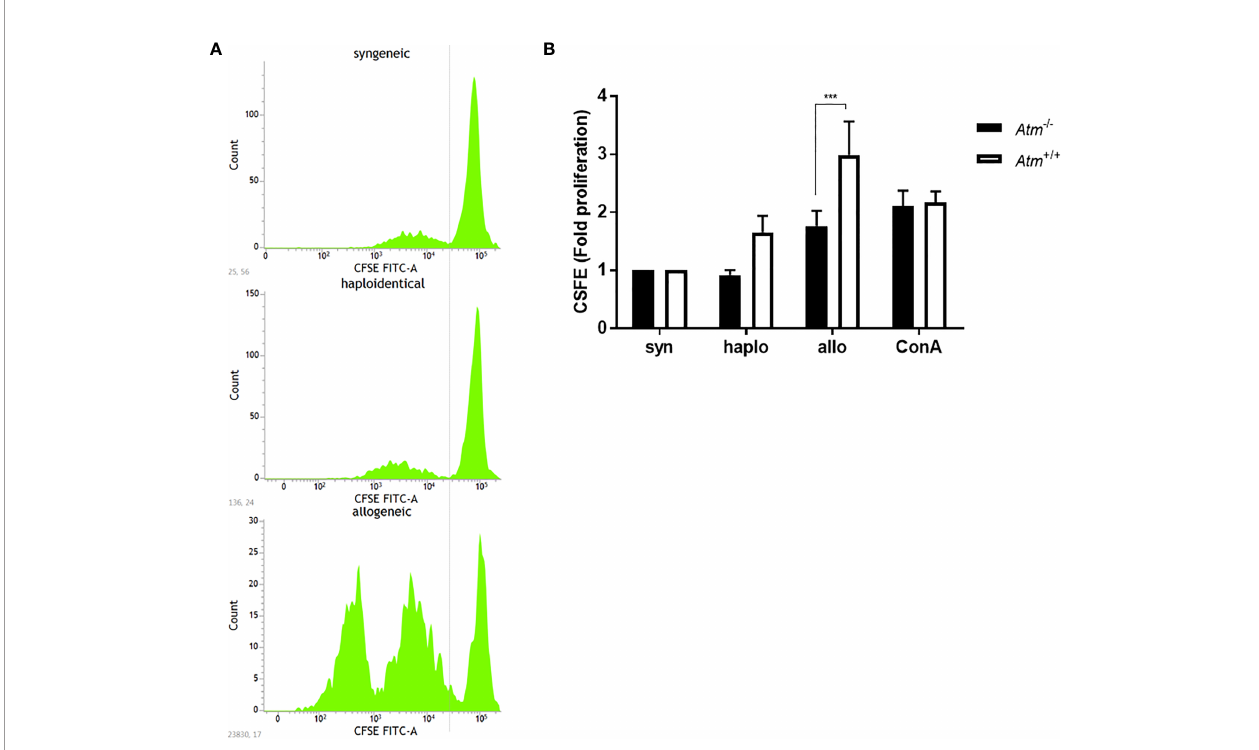
FIGURE 1 | Proliferation of DCs in Atm -/- and Atm +/+ mice following stimulation with syngeneic, haploidentical and allogeneic T-cells in vitro . (A) Representative CFSE intensity histograms showing the mean level of the CFSE expression per generation of T-cells isolated from spleens of syngeneic, haploidentical and allogeneic donor mice. (B) Cell proliferation of T-cells isolated from spleens of syngeneic, haploidentical and allogeneic donor mice and cocultured with DCs isolated from Atm -/- and Atm +/+ mice (n = 8) was followed for 4 days using the CFSE cell proliferation kit. Data were normalized to the syngeneic T-cells and compared to haploidentical and allogeneic T-cell proliferative capacity. Data are presented as mean ± SEM. *** p < 0.001. CFSE, carboxy- fl uorescein diacetate succinimidyl ester; DC, dendritic